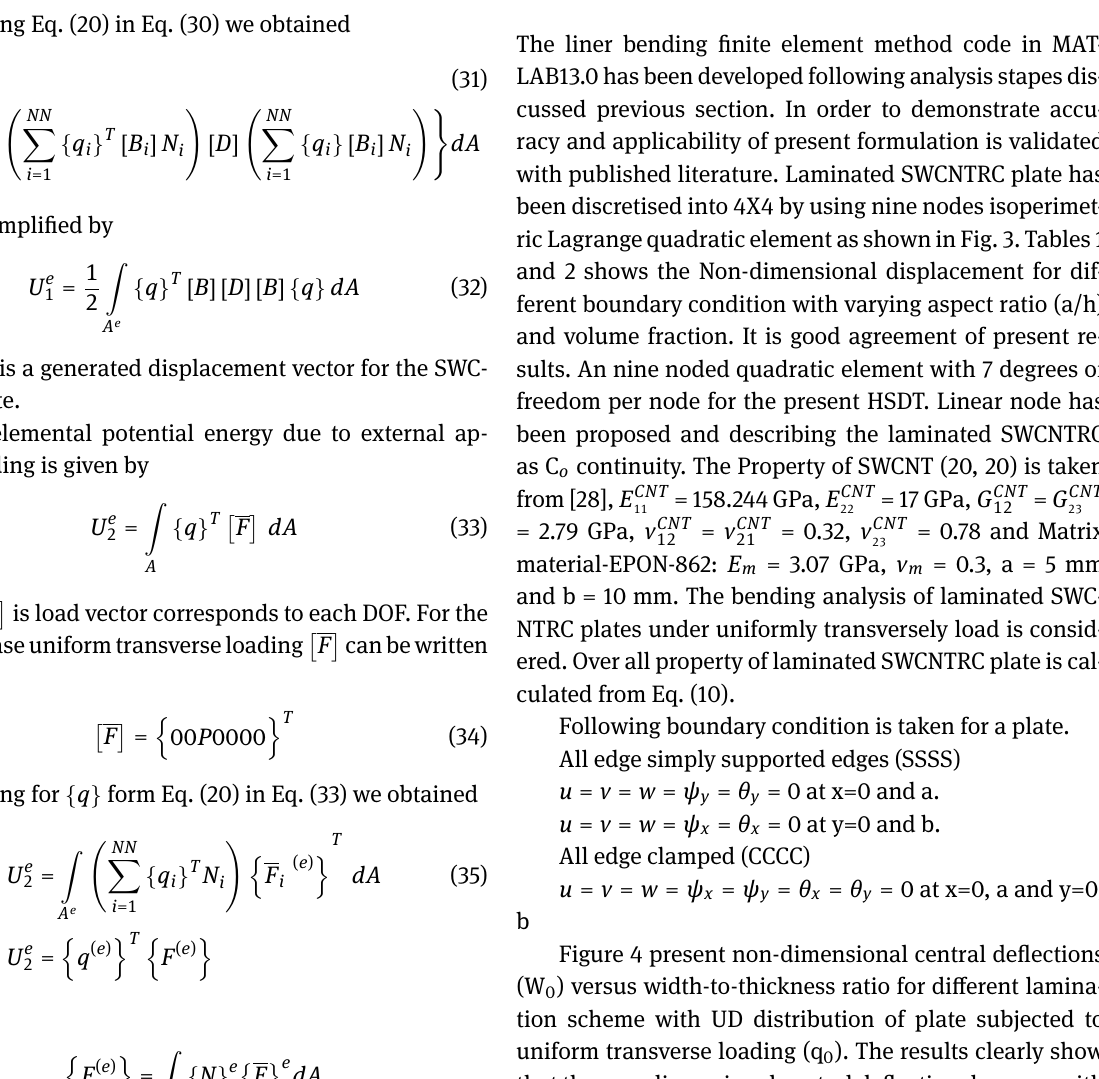
Figure 4 present non-dimensional central deflections (W 0 ) versus width-to-thickness ratio for different lamina- tion scheme with UD distribution of plate subjected to uniform transverse loading (q 0 ). The results clearly show that the non-dimensional central deflection decrease with an increase the width-to-thickness ratio. All lamination schemes have significant results of the a/h ratio up to 20 and rest of the value is